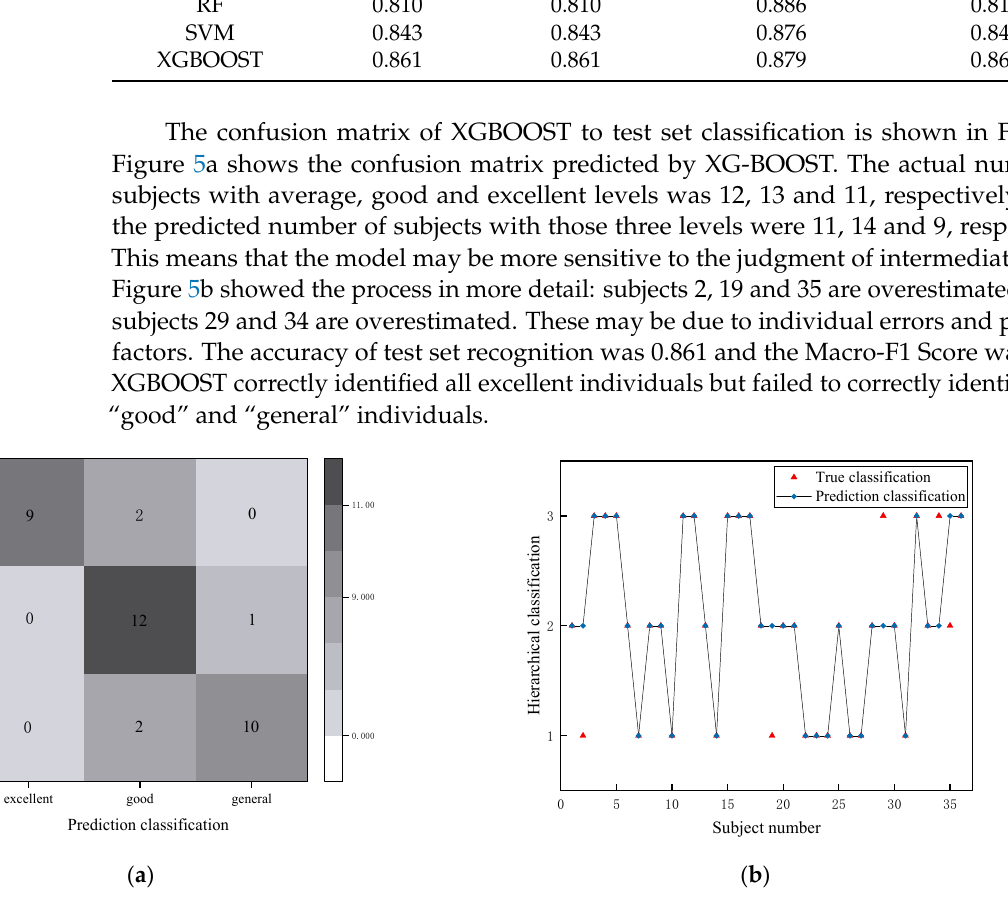
Figure 5. ( a ) Confusion matrix predicted by XGBOOST; ( b ) Hierarchical